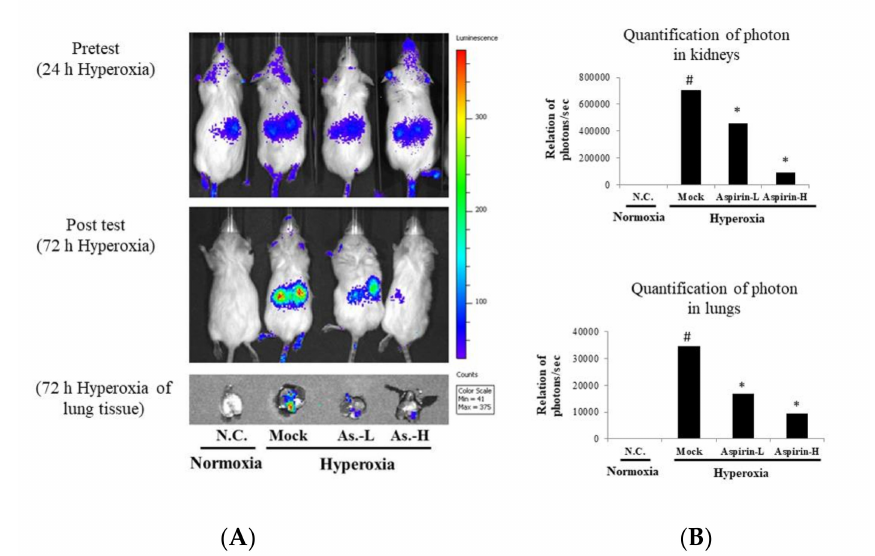
Figure 3. ( A ) Bioluminescence imaging of kidney and lung tissues and ( B ) photon quantification of kidney and lung tissues in NF- κ B–luciferase transgenic mice after induction of hyperoxia for 72 h in the normal control (NC), mock, aspirin-L and aspirin-H groups. The reported values are expressed as the mean ± SEM ( n = 6). # p < 0.05 vs. NC group. * p < 0.05 vs. mock